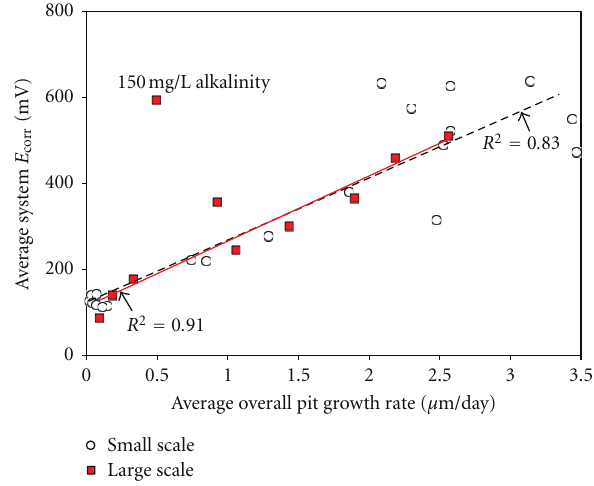
Figure 5: Average system E corr versus overall pit growth rate for all tests. The 150mg/L alkalinity condition did not follow the same trend as other data and is not included in the computed R 2 value for the large-scale tests.